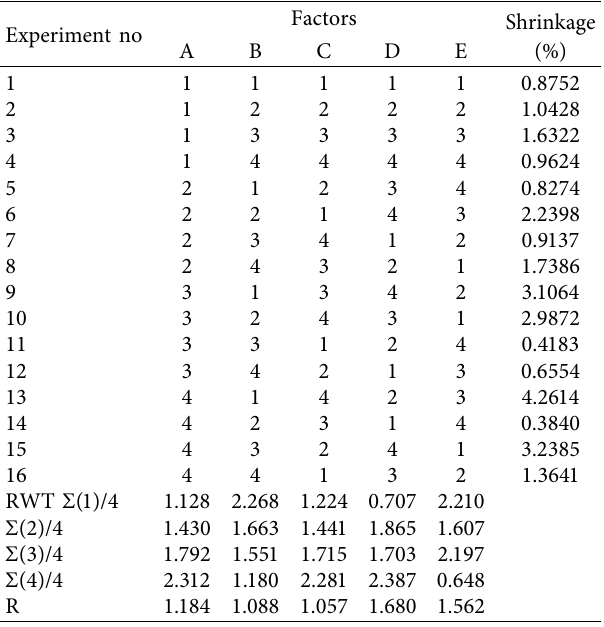
Table 4: L 5 ) orthogonal array used in experiment and 16 (4